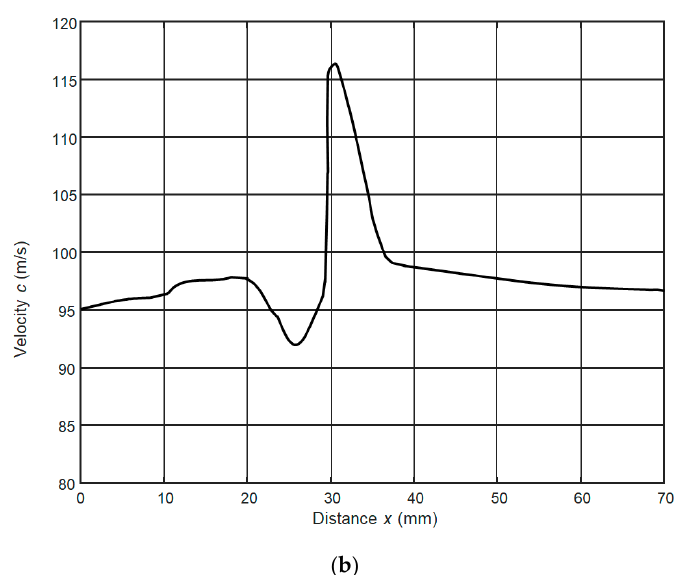
Figure 11. Simulated B-scan of the MICA sample with a single circular non-uniformity ( a ) and spatial distribution of the phase velocity of A 0 mode along the line y = 0 mm in the case of the single circular non-uniformity ( b ).